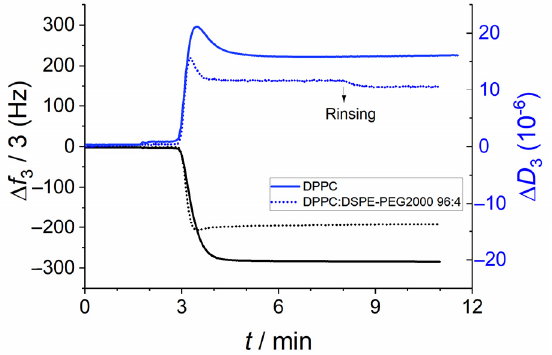
Figure 10. QCM-D signals (3rd overtone) obtained from the adhesion, of DPPC (solid lines) and DPPC:DSPE-PEG2000 (96:4 moL%—dotted lines) liposomes on a silica surface at 21 °C.